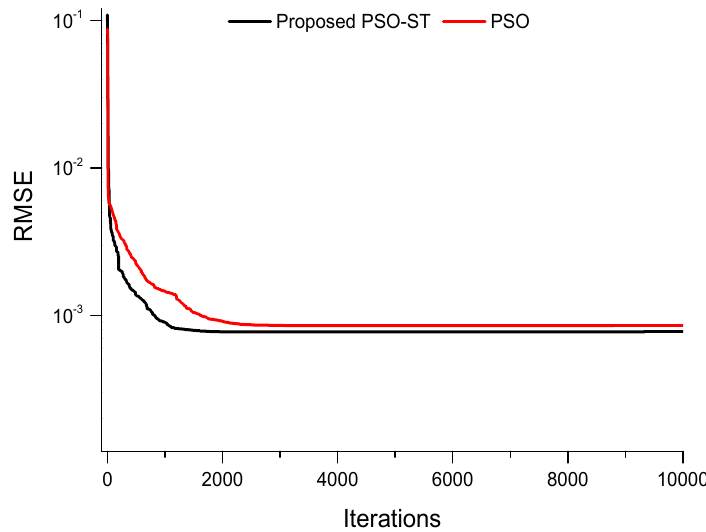
Figure 8. Convergence characteristics of DDM, solar cell. Table 4. Obtained statistical results for the SDM solar cell.